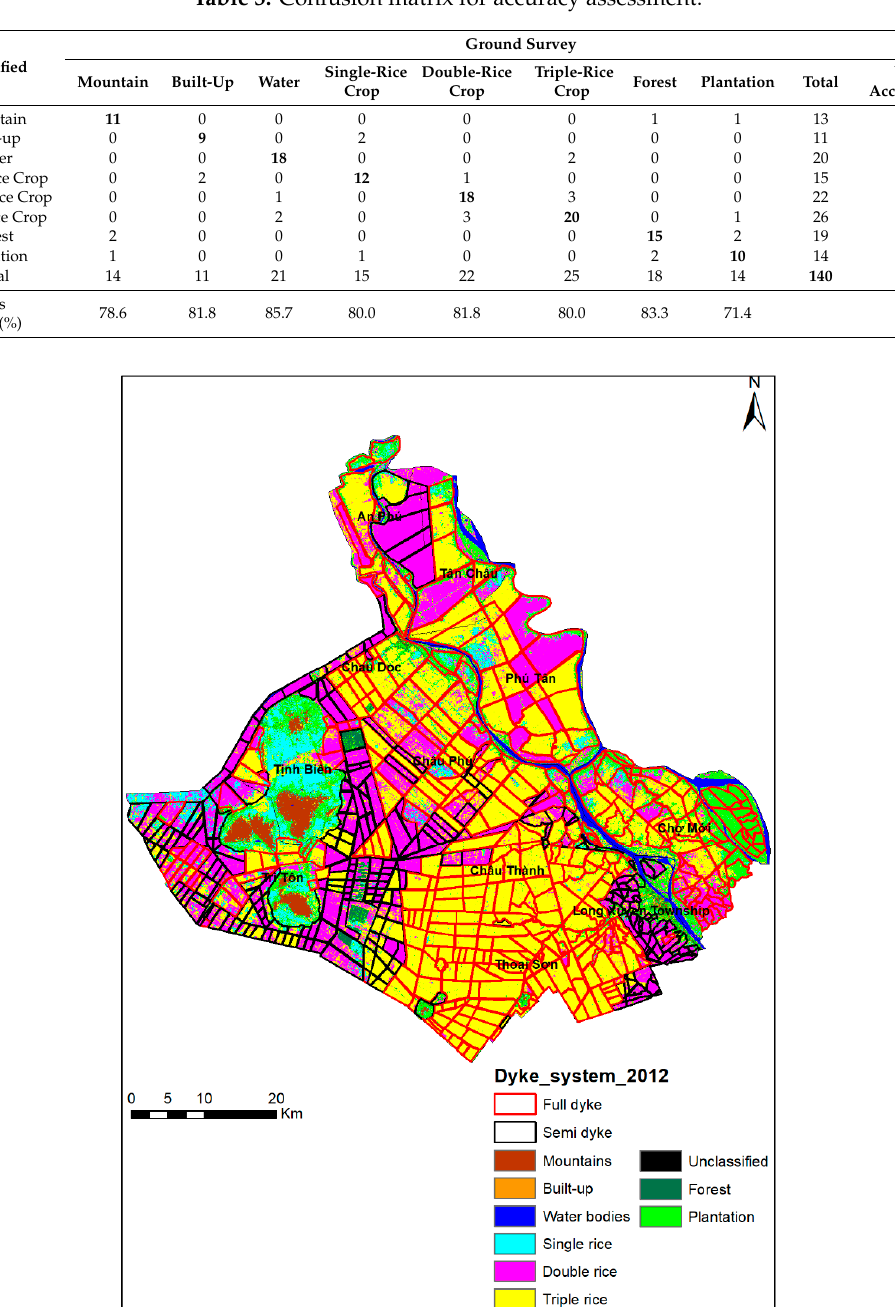
Figure 12. Distribution of various land cover classes and dike system. Table 3. Confusion matrix for accuracy assessment.